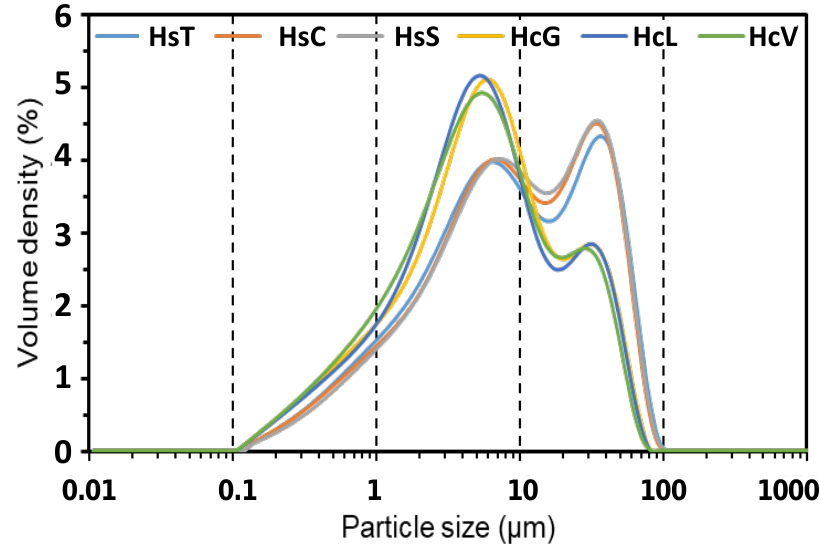
Figure 2. Laser di ff raction-determined particle size distribution in fine particle CDW.